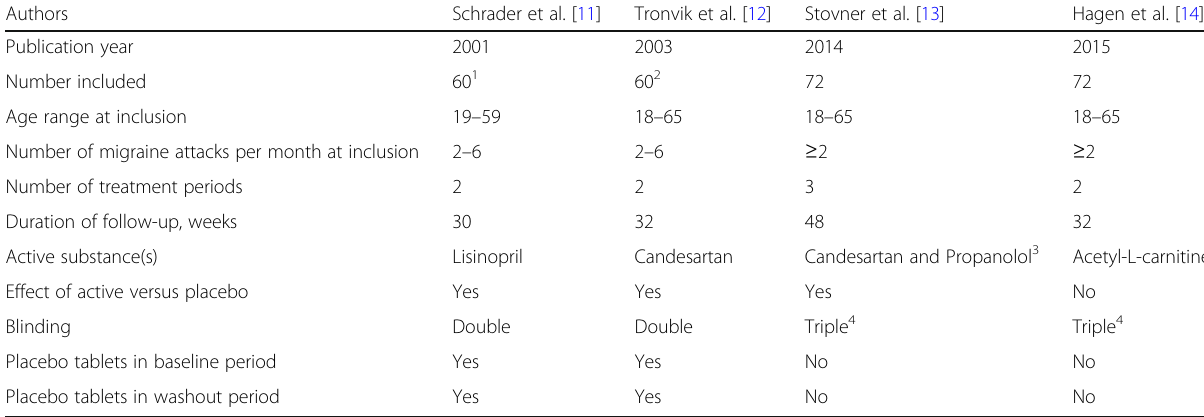
Table 1 Summary of study details which differ between